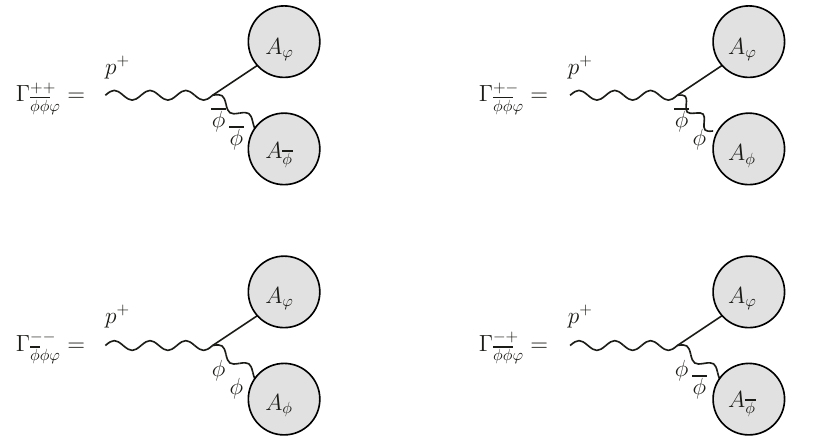
Figure 4 . The contribution of graphs with a double off shell 3pt vertices with nontrivial single vector soft